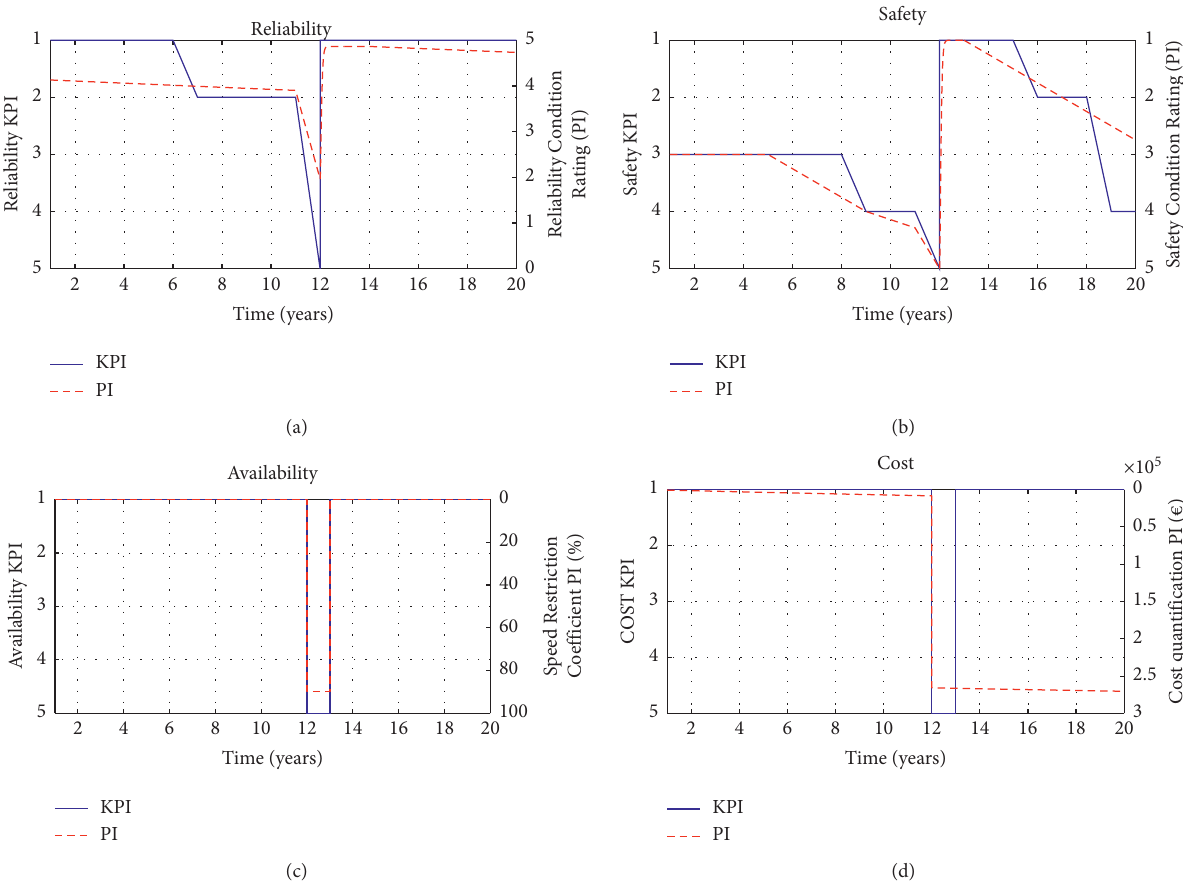
Figure 10: Bridge performance condition considering corrective scenario: (a) reliability; (b) safety; (c) availability; (d)